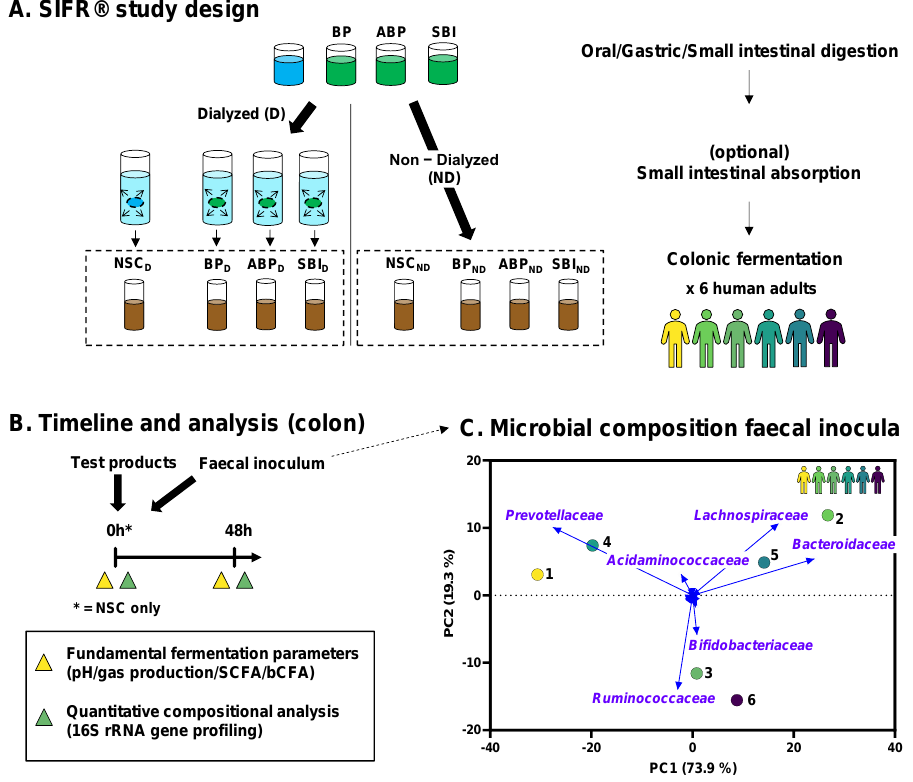
Figure 1. Experimental design to study small intestinal digestion and colonic fermentation in the presence of different protein fractions (BP, ABP, and SBI) using the ex vivo SIFR ® technology . ( A ) Digested protein fractions were subjected to a simulation of absorption via dialysis (D) or tested as such in 48 h colonic incubations (ND). These colonic incubations were performed to assess the fermentation of the three bovine plasma protein fractions by the human gut microbiota of human adults compared to a NSC ( n = 6). ( B ) Sampling and analysis were performed to evaluate the effect on fundamental fermentation parameters and microbial composition. ( C ) PCA based on centered abundances at the family level (%) demonstrating the variation across the fecal microbiota of the six human adults. BP = bovine plasma, ABP = albumin-enriched bovine plasma, SBI = serum-derived Bovine Immunoglobulin, D = dialysis, ND = no dialysis, NSC = no substrate control, SCFA = short-chain fatty acid, bCFA = branched-chain fatty acid, PCA = principal component analysis, and SIFR = systemic intestinal fermentation research.